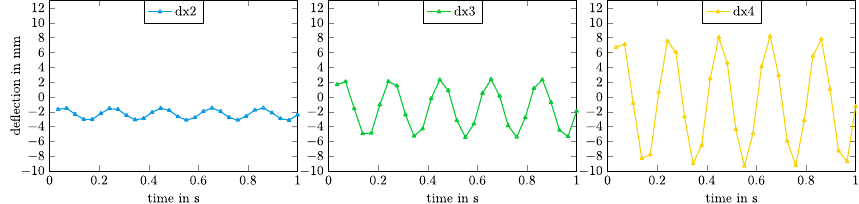
Figure 15. Measured time course for the deflections dx2 ( left ), dx3 ( middle ) and dx4 ( right ) at a 5.0 Hz switching frequency at a voltage of 4000